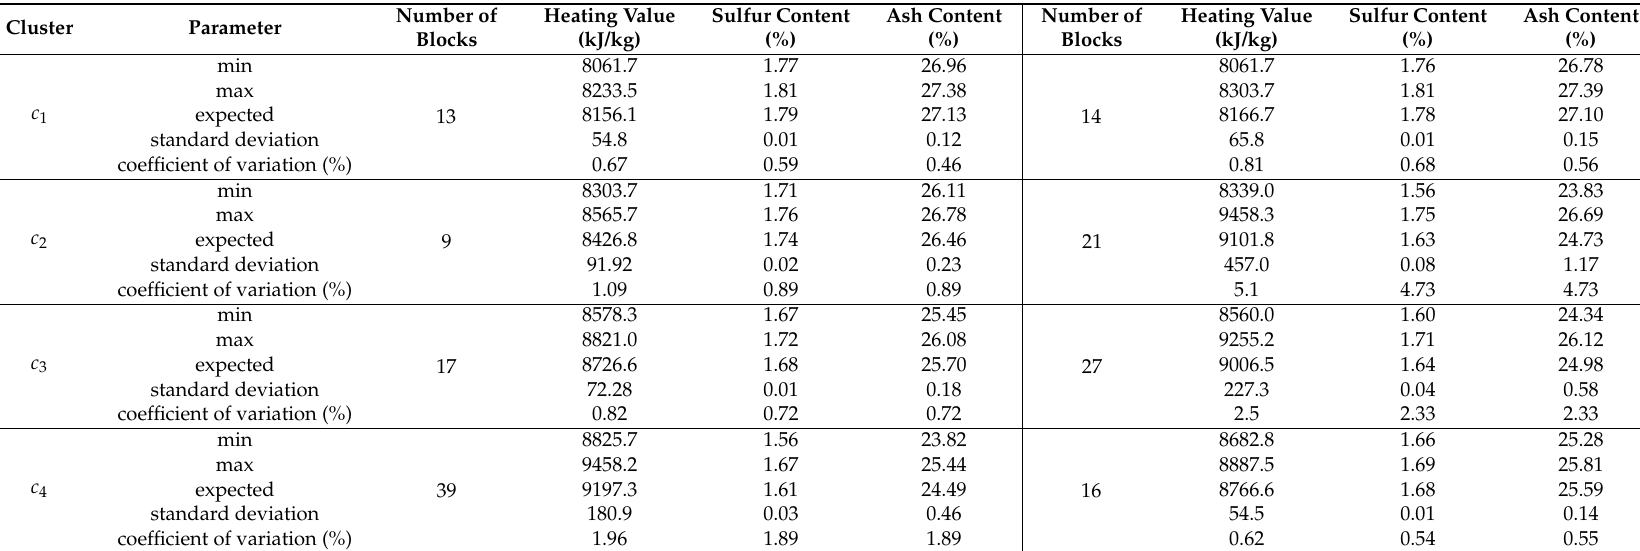
Table 8. Summary statistics of clusters for the matrix (78 × 4) and (78 ×